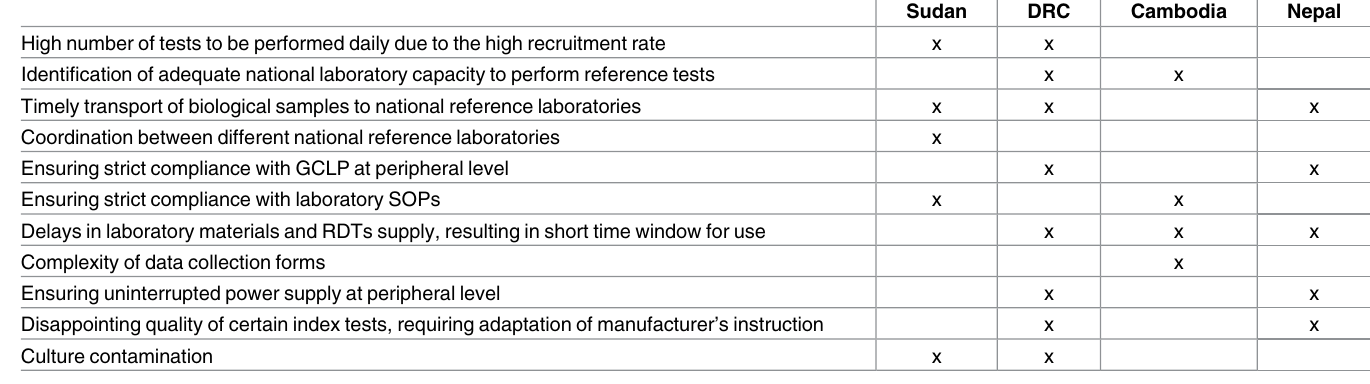
Table 2. Challenges encountered by the laboratory staff during the NIDIAG persistent fever syndrome study.